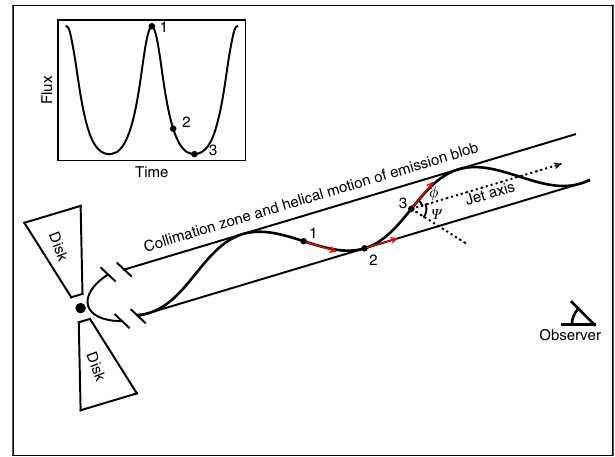
Fig. 4 Schematic illustration of a helical jet that produces periodically modulated emission. The emitting blob ’ s motion has a pitch angle ϕ from the jet ’ s axis, which has an inclination angle ψ from the line of sight. As the emitting blob moves towards the observer, the viewing angle to the blob changes